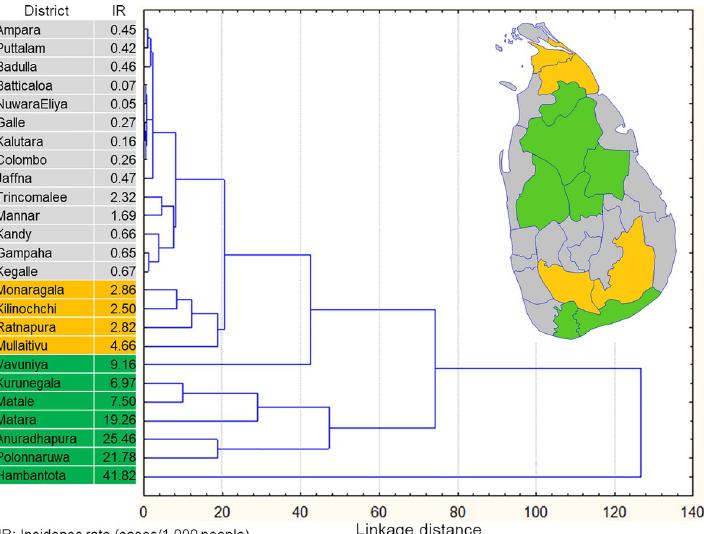
Fig 3. Classification of study areas by disease dynamics at each district. Source: Authors’ own map using data from https://data.humdata.org/dataset/sri-lanka-administrative-levels-0-4-boundaries.